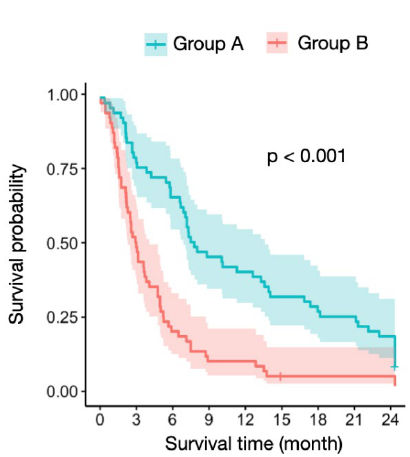
Figure A2. Survival curves of groups A and B Blue and red line presents survival curve of groups A and B, respectively. Area with lighter color represents the 95% confidence interval. Group A comprises patients with an ATS more or equal to 8 points. Group B comprises patients with an ATS less than 8. Abbreviation: ATS = adjusted Tokuhashi score.